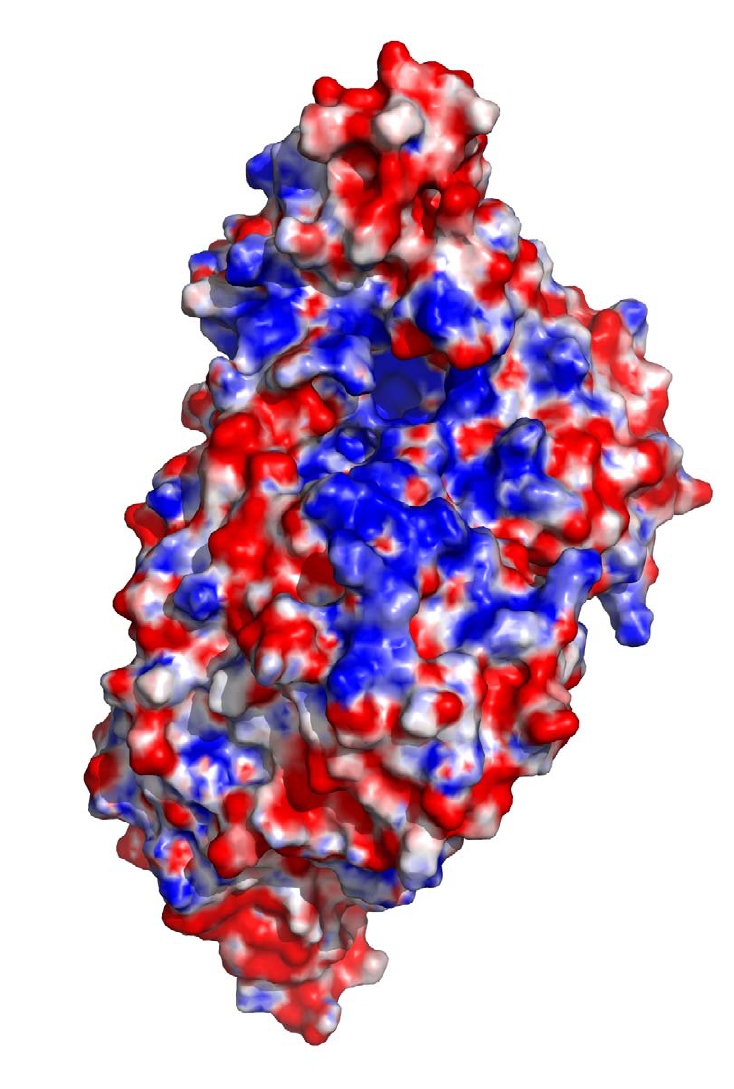
Figure 8. The electrostatic potential of the IscS dimer: red, negative; blue, positive. Surface with positive potential overlaps with the footprint of CyaY and IscX. Orientation similar to that in Figure 6B.